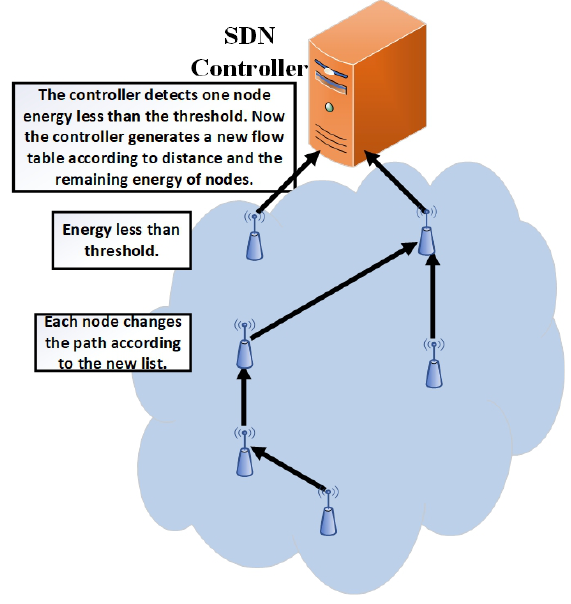
Figure 7. Updating phase